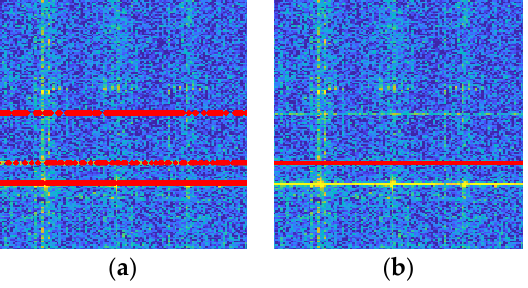
Figure 8. Marking of prediction results of different clustering algorithms ( k = 2): ( a ) K-means; ( b ) BIRCH.